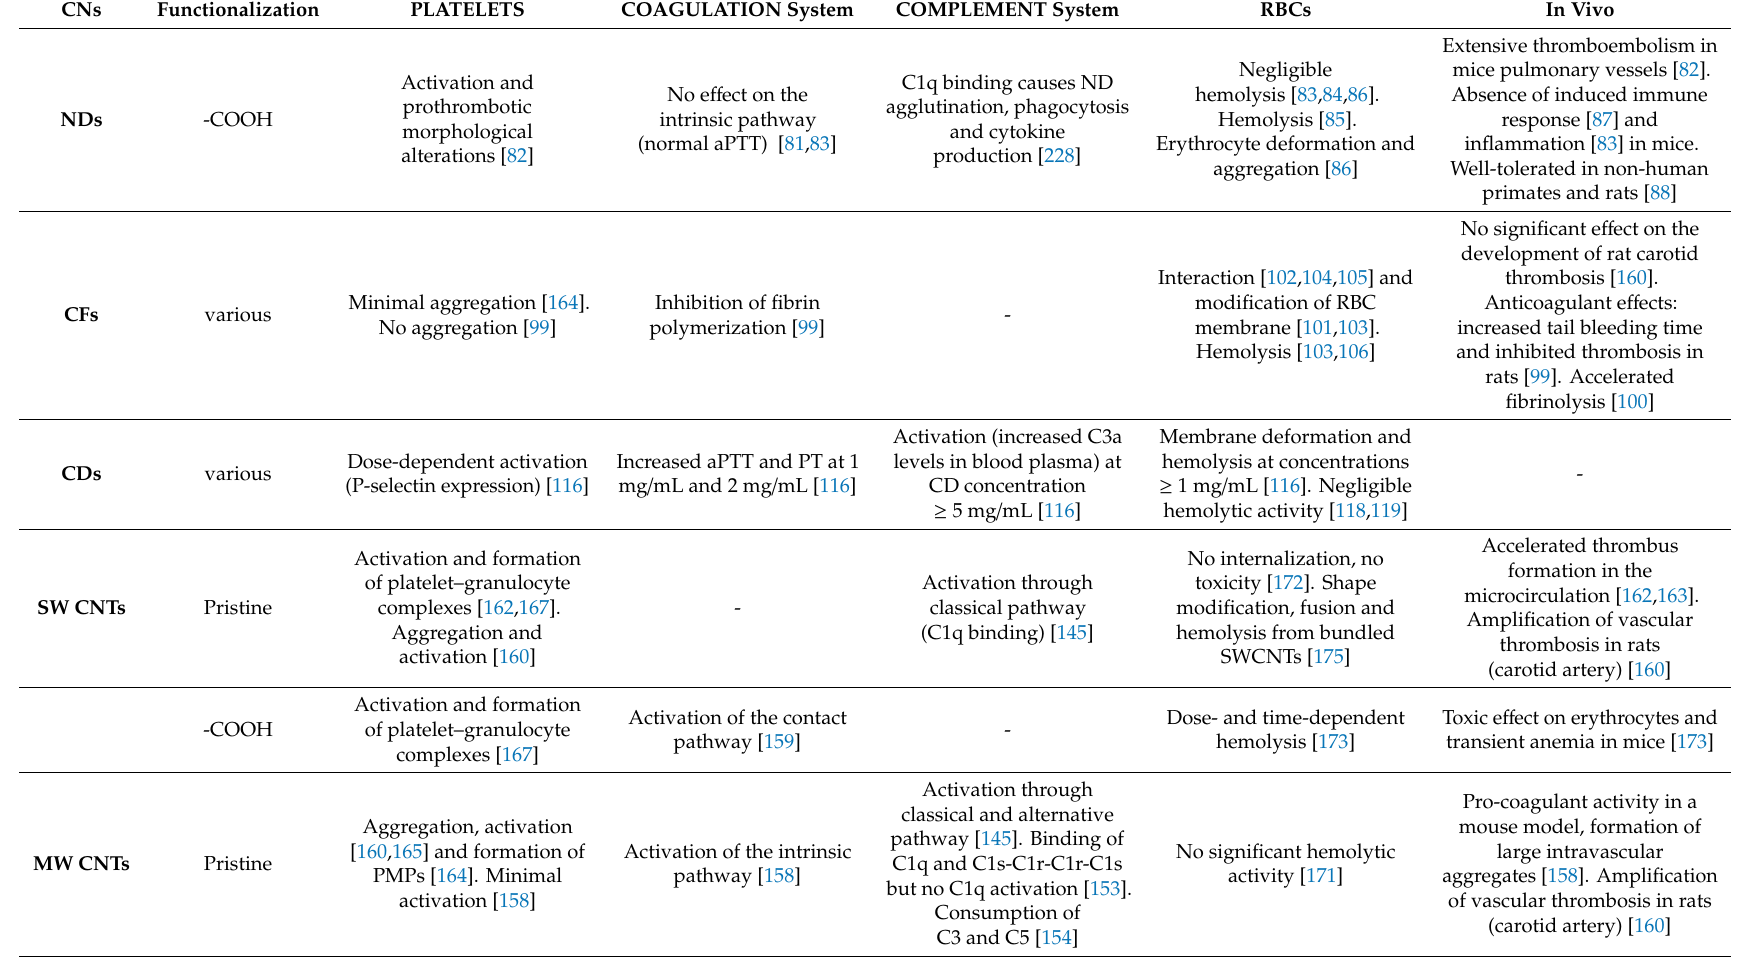
Table 1. Main outcomes of hemocompatibility studies for di ff erent classes of